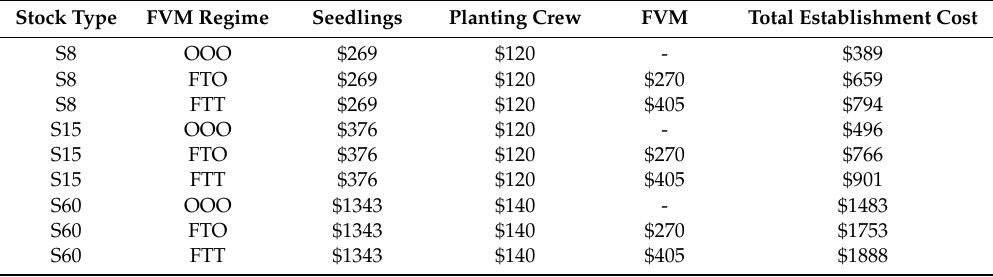
Table 5. Establishment costs (in 2008 USD) per hectare for di ff erent combinations of stock type and forest vegetation management (FVM) regimes. Seedling and planting cots assume a planting density